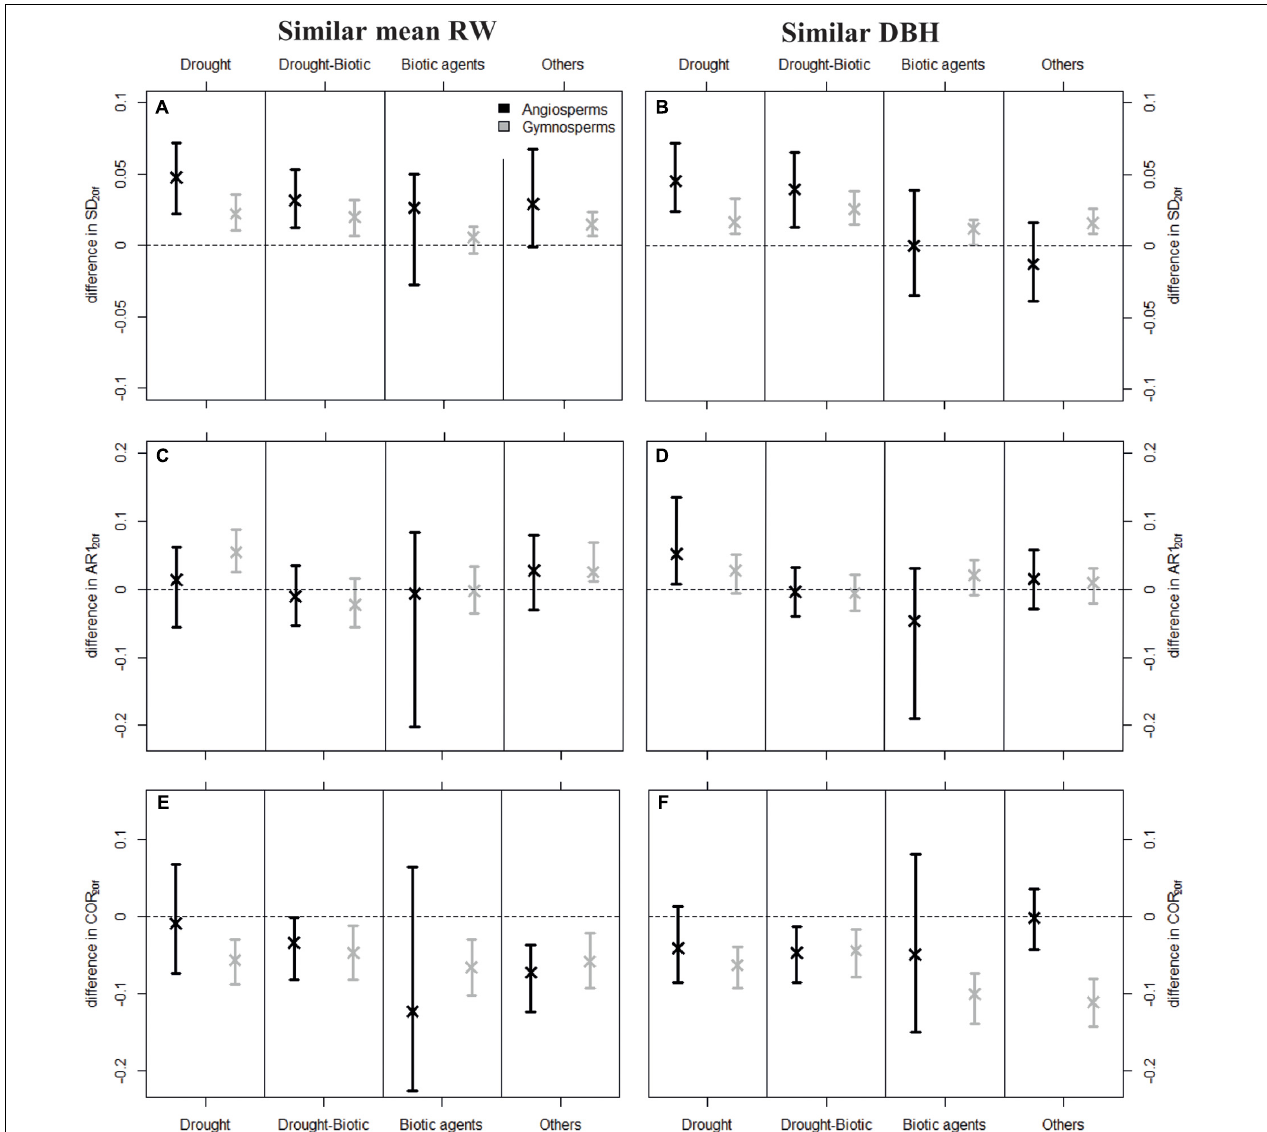
FIGURE 4 | Mean difference in SD 20 f (A,B) , AR1 20 f (C,D) , and COR 20 f (E,F) values between dying and surviving trees predicted by the linear mixed-effects models (LMMs) fitted to the original dataset, fixing diff D − S RW 20 f and diff D − S DBH f at zero. Positive values mean that dying trees showed higher SD 20 f , AR1 20 f , or COR 20 f compared to conspecific surviving trees. Standardization was based on similar meanRW 20 f ( Left ) and similar DBH f ( Right ). Error bars depict 95% confidence intervals of the predicted mean differences, which were determined from 500 bootstrap resamplings. Estimates of the LMMs are available in Supplementary Table H1